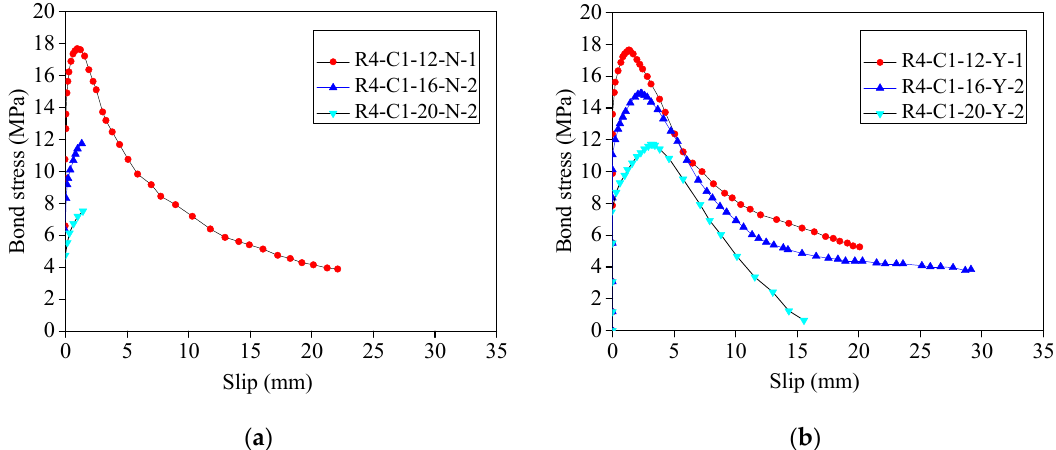
Figure 8. Representative τ - s curves for R4 bars for the ( a ) without and ( b ) with stirrups.